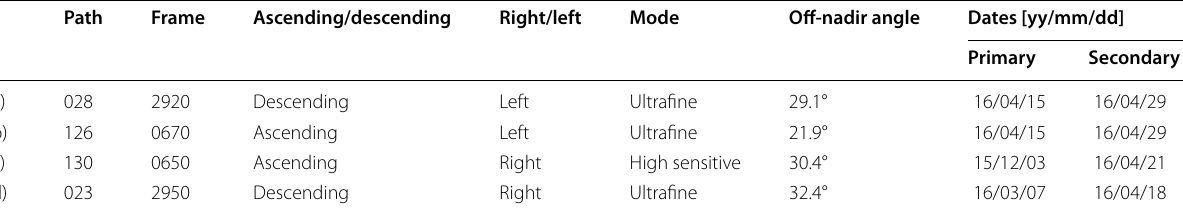
Table 1 ALOS-2 data utilized in this